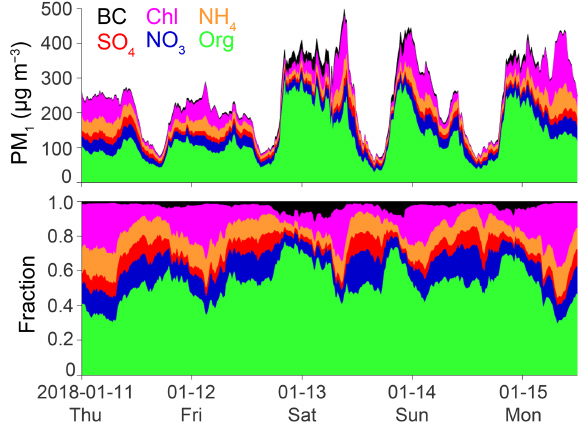
Figure 9. Time series of PM 1 species (Org, Chl, NH 4 , NO 3 , SO 4 , and BC) – stacked absolute concentrations and fraction of PM 1 – for a period with high organic PM concentration coinciding with the Lohri bonfire festival of 15 January